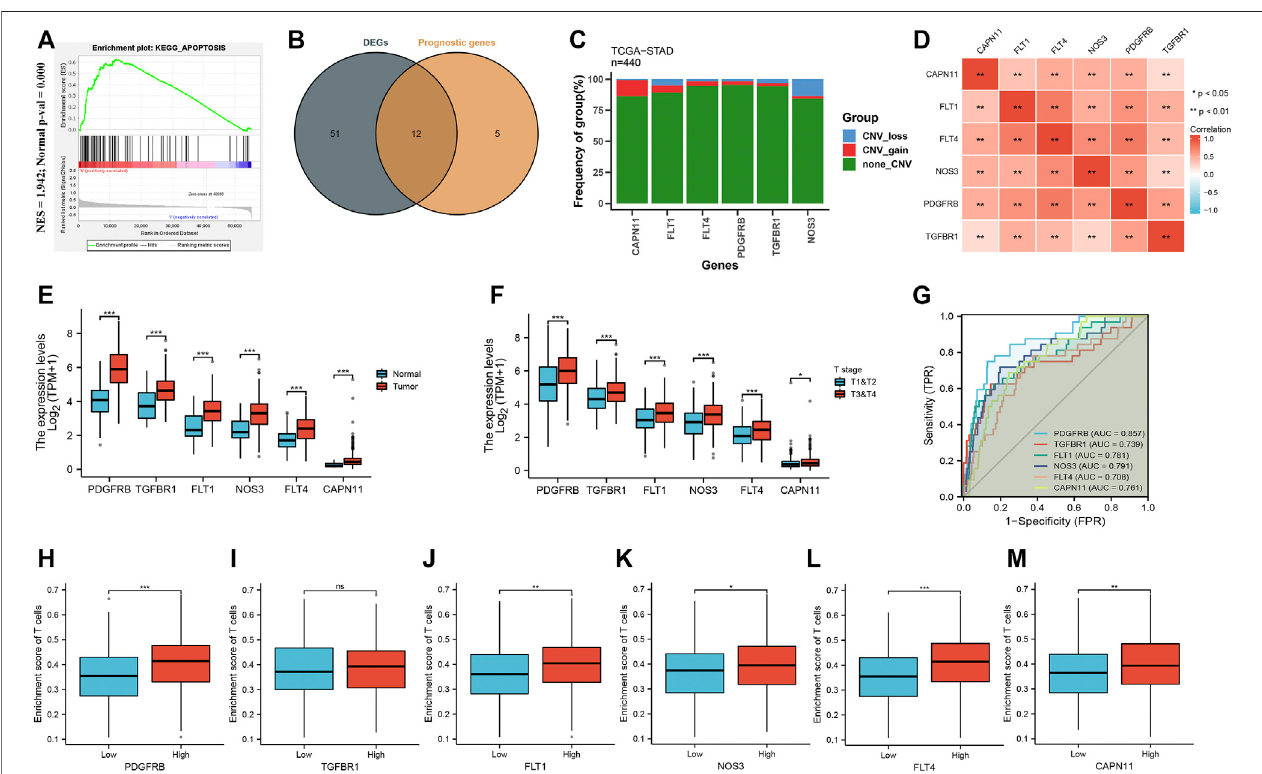
FIGURE2| Identi fi cationofdifferentialexpressionandprognosticofARGsinTCGA-STAD. (A) GSEAshowedthattheapoptosispathwayaredifferentiallyenriched in GCpatients. (B) Venndiagramtoidentifydifferentially expressed genesbetween tumor andnormaltissue thatwerecorrelatedwithoverallsurvival. (C) Frequenciesof CNV gain, loss, and non-CNV among six ARGs. (D) Correlation heat map of six ARGs. The size of the colored squares represents the strength of the correlation; red represents a positive correlation. The darker the color is, the stronger correlation is. (E) The illustration shows the expression distribution of six ARGs between normal (blue) and GC (red) tissues. (F) The illustration shows the expression distribution of six ARGs between T1&T2 (blue) and T3&T4 (red). (G) ROC analysis showing that six ARGs has good diagnostic performance. (H – M) The correlation between the expression of six ARGs and enrichment score of T